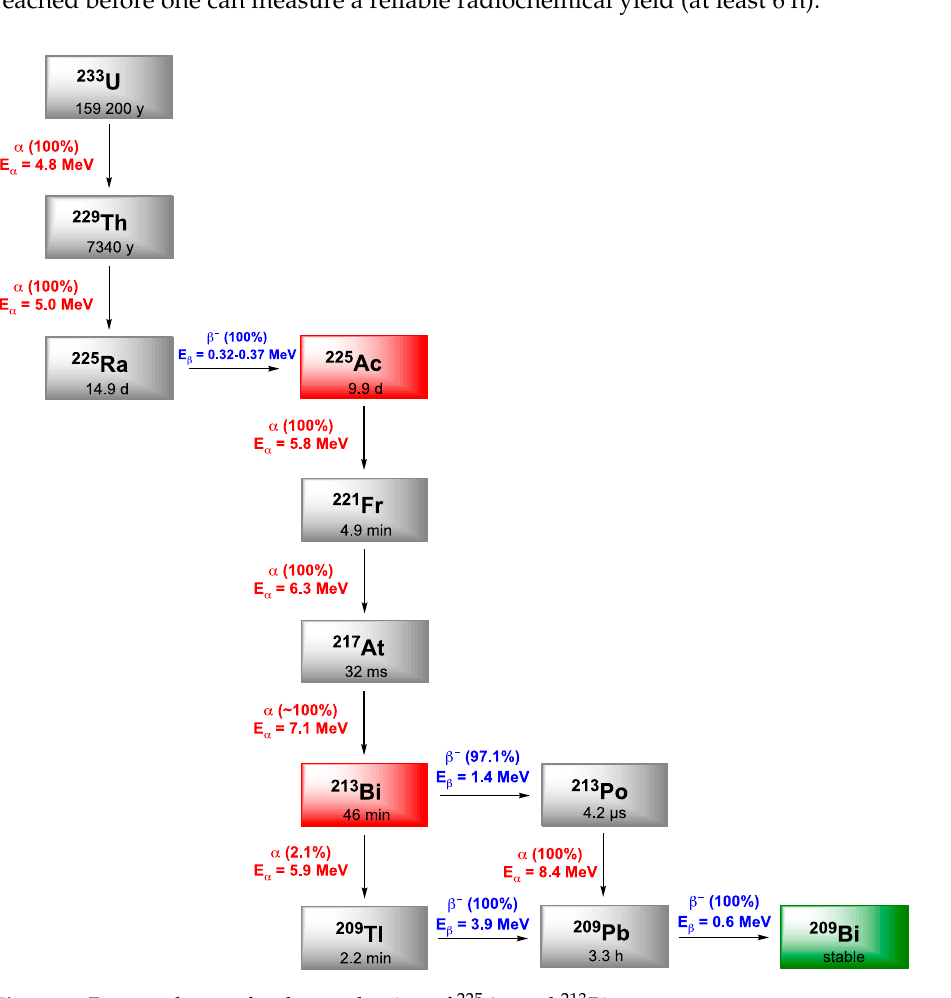
Figure 1. Decay schemes for the production of 225 Ac and 213 Bi.